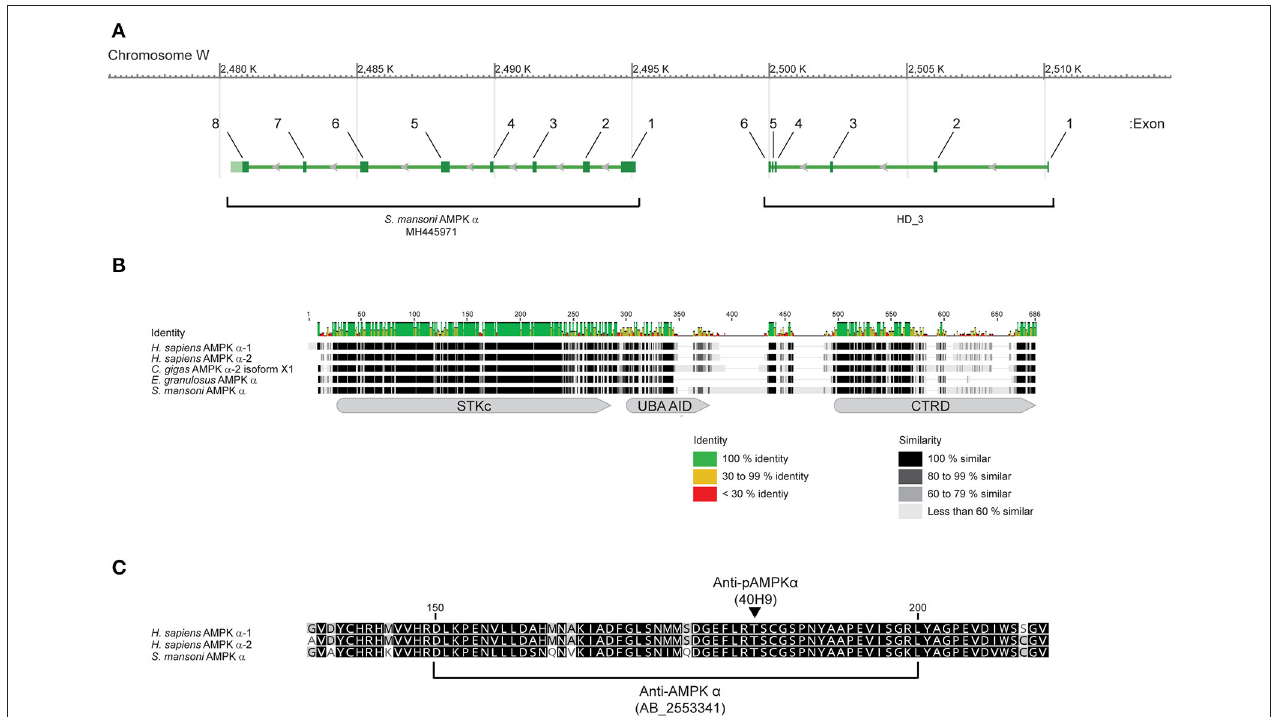
FIGURE 1 | Sequence and structure of S. mansoni AMPK α . (A) Arrangement of the eight exons that contribute to the S. mansoni AMPK α mRNA MH445971, on the complementary strand of the W chromosome. Six exons that encode for a metal-dependent phosphohydrolase (HD_3) domain are located upstream, separated by 5kb of intergenic sequence. (B) The amino acid sequence of S. mansoni AMPK α (MH445971) aligned with sequences of Homo sapiens AMPK α -1 (NP_006242) and AMPK α -2 (NP_006243), Crassostrea gigas AMPK α -2 (XP_011446066), and Echinococcus granulosus AMPK α (AER10553), showing sequence identity and similarity, and the approximate locations of the AMPK α serine/threonine kinase catalytic domain (STKc, CCD accession number cd14079), AMPK α UBA-like autoinhibitory domain (UBA AID, CCD accession number cd14336), and AMPK α C-terminal regulatory domain (CTRD, CCD accession number cd12122). Amino acid numbering refers to the consensus sequence for the alignment. (C) Alignment of H. sapiens AMPK α -1 (NP_006242) and AMPK α -2 (NP_006243), and S. mansoni AMPK α (MH445971), in the region recognized by a rabbit polyclonal antibody (RRID AB_2553341) raised against aa 150–200 of human AMPK α -1 (NP_006242). The square brackets denote the 50 aa sequence of NP_006242 used as the immunogen. The arrowhead indicates the position of the activation loop threonine that is phosphorylated upon activation, corresponding to Thr183 and Thr172 of NP_006242 and NP_006243, respectively, and Thr176 of the